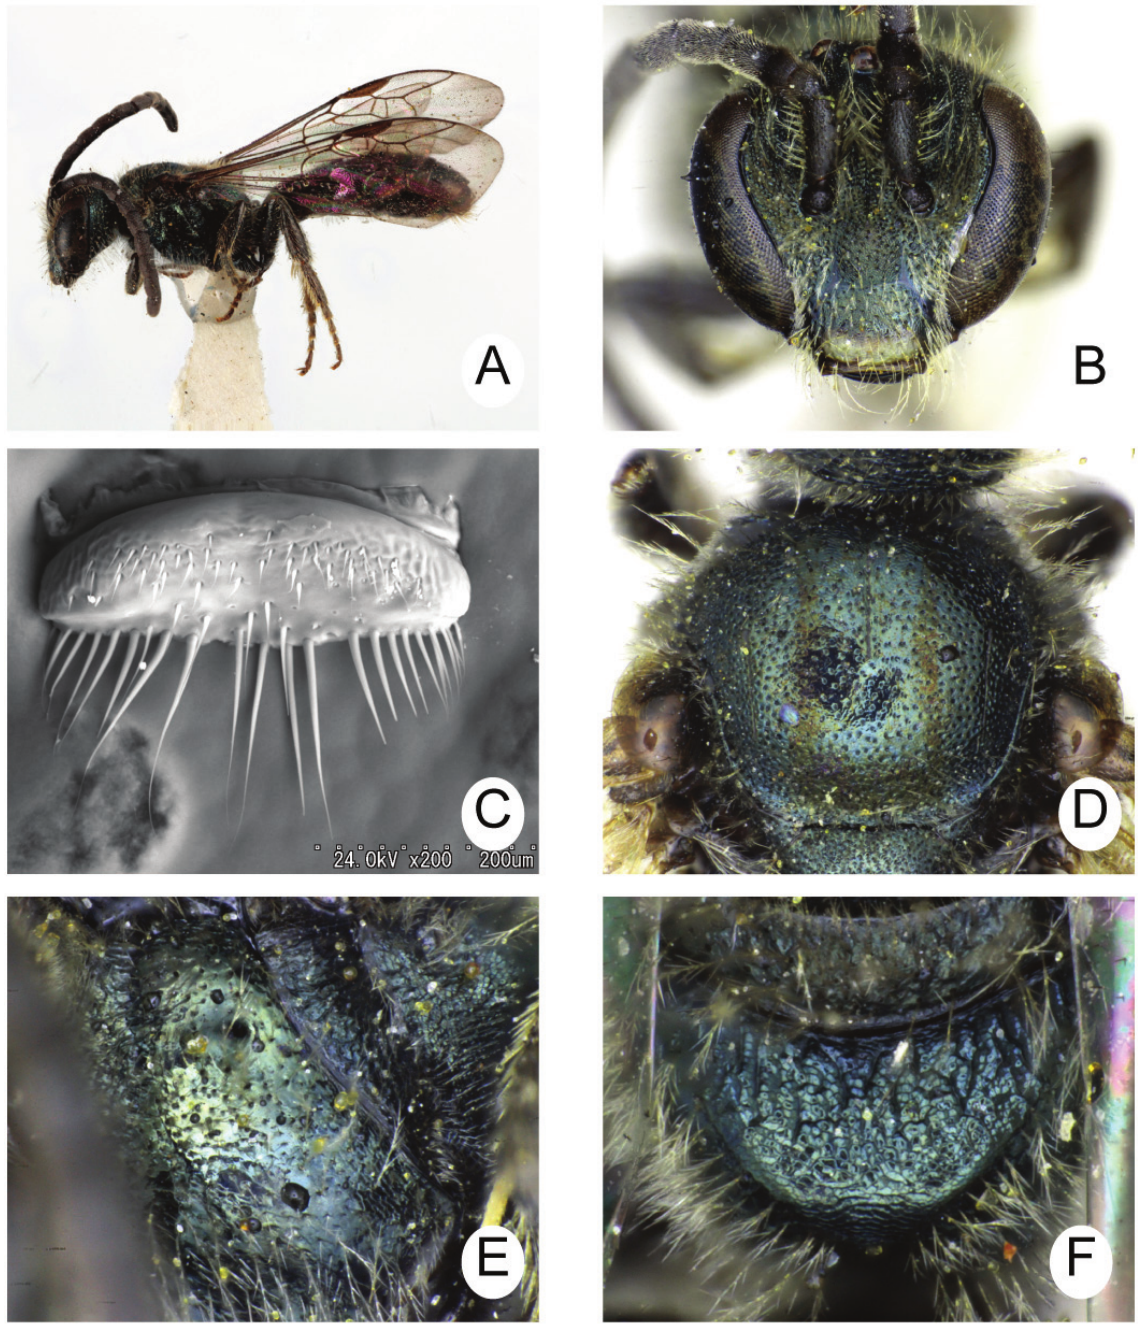
Fig. 10. Lasioglossum ( Dialictus ) taiwanense Murao sp. nov., ♂. A . Lateral habitus. B . head in frontal view. C . Labrum. D . Mesoscutum. E . Mesepisternum. F . Metapostnotum. a–B, e–F. holotype. c–d.